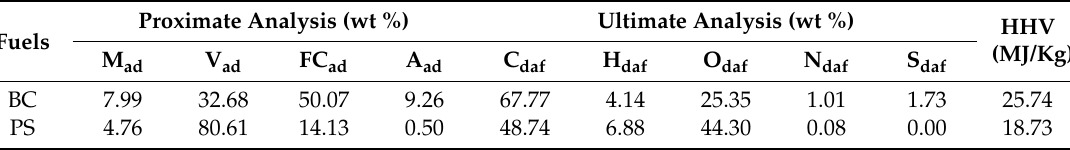
Table 1. Properties of fuel samples (daf, dry-ash-free).